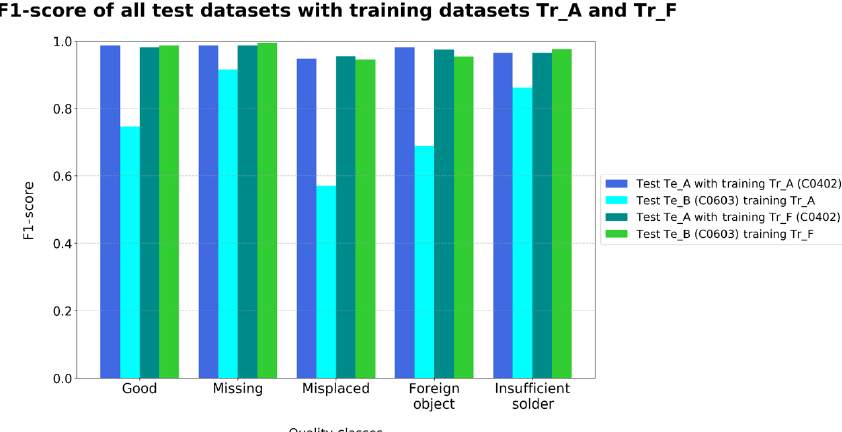
Figure 9. F1-Score on capacitors C0402 and C0603 depending on the different training datasets.